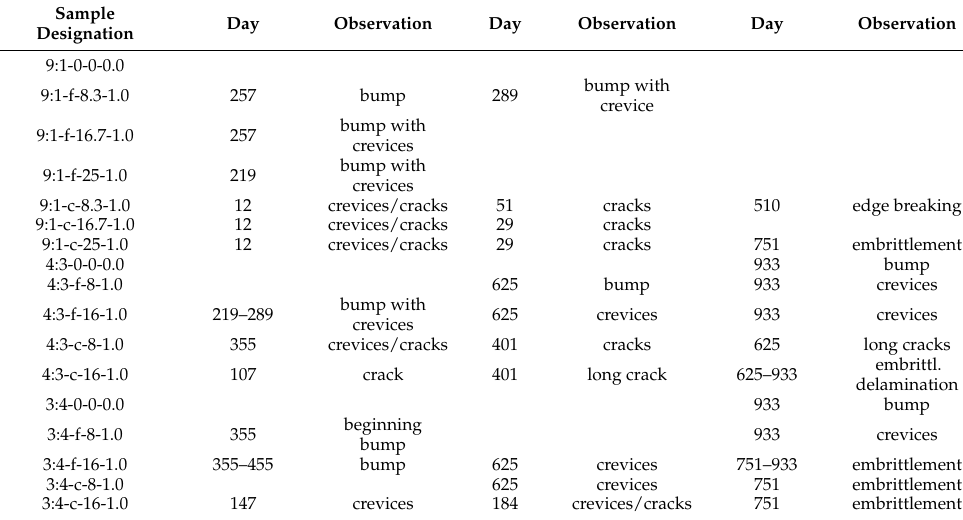
Table 2. Observations during weighing of test specimens from water sorption; all samples with coarse SBP type show open bumps at the surfaces within 1 day; embrittlement: test specimen will break when torque is applied during drying of the wet specimen.